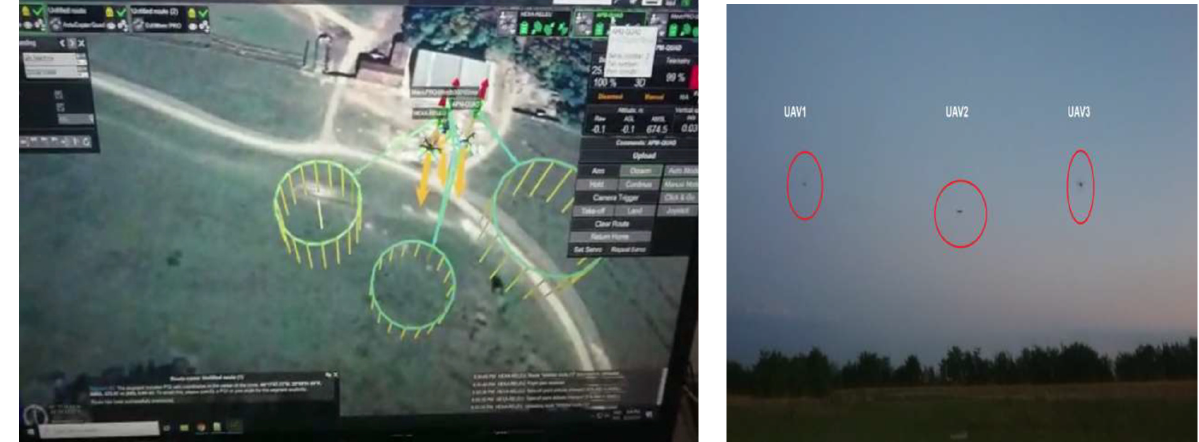
Figure 8. Implementation of specific control elements to ensure the functional operation of air vectors in a collaborative regime: testing 19 Sol/UAV solution.